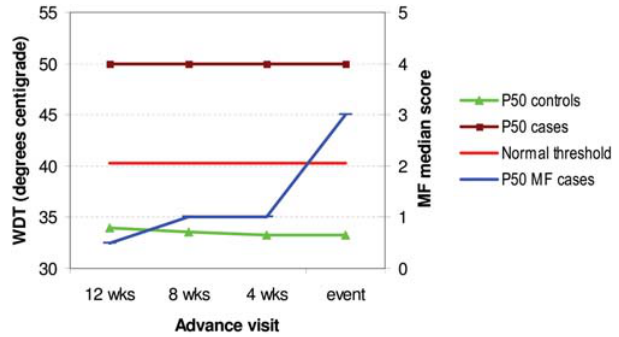
Figure 3. Trend in WDTs in the sural nerve prior to a sensory impairment event detected by monofilaments (case nerves: n=8; control nerves: n=16). ‘Cases’ are nerves with new sensory impairment by monofilament (MF) test at time ‘0’; ‘controls’ are nerves without any clinically detectable sensory impairment during follow-up; P50=median value; normal threshold refers to the specific parameter tested (here warm detection thresholds).